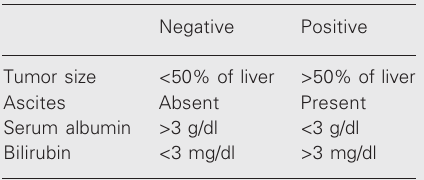
Table 1. Okuda classification of hepatocellular carcinomas